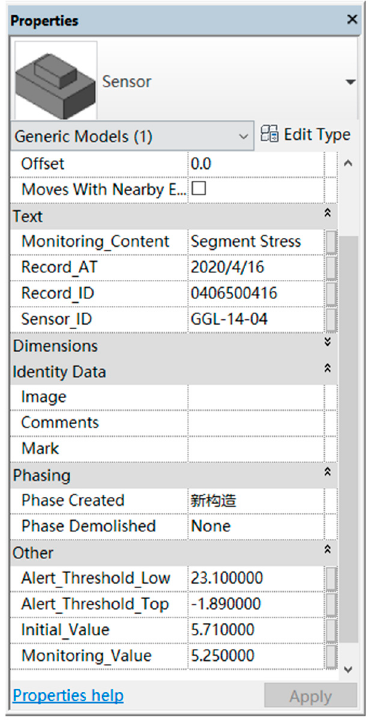
Figure 9. Properties of the stress sensor in the BIM model.